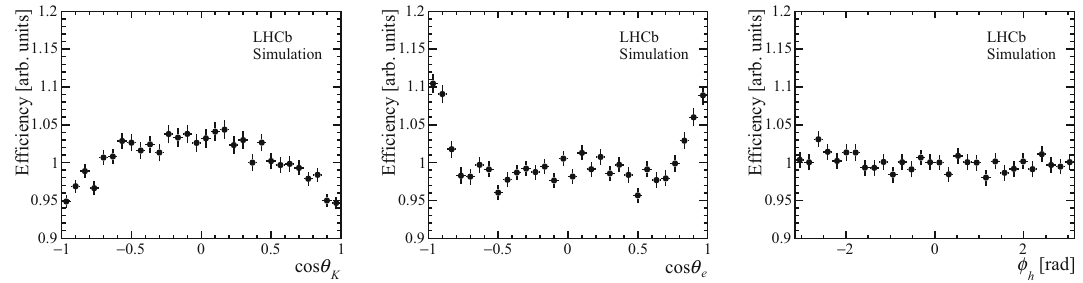
Fig. 5 Efficiency projected onto (left) cos θ K , (middle) cos θ e and (right) φ h obtained from a simulated B 0 s → J /ψφ sample, scaled by the average efficiency